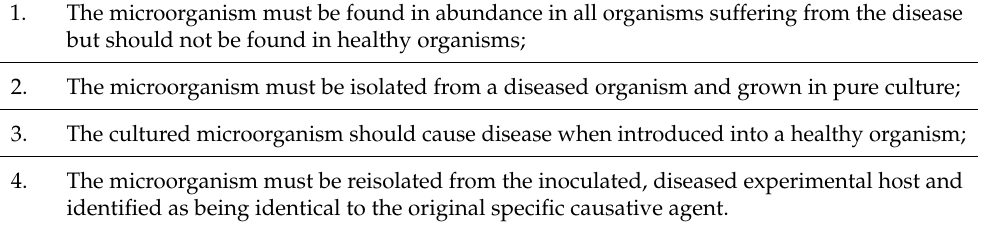
Table 1. Koch and Löffler 1884 postulates in their original formulation